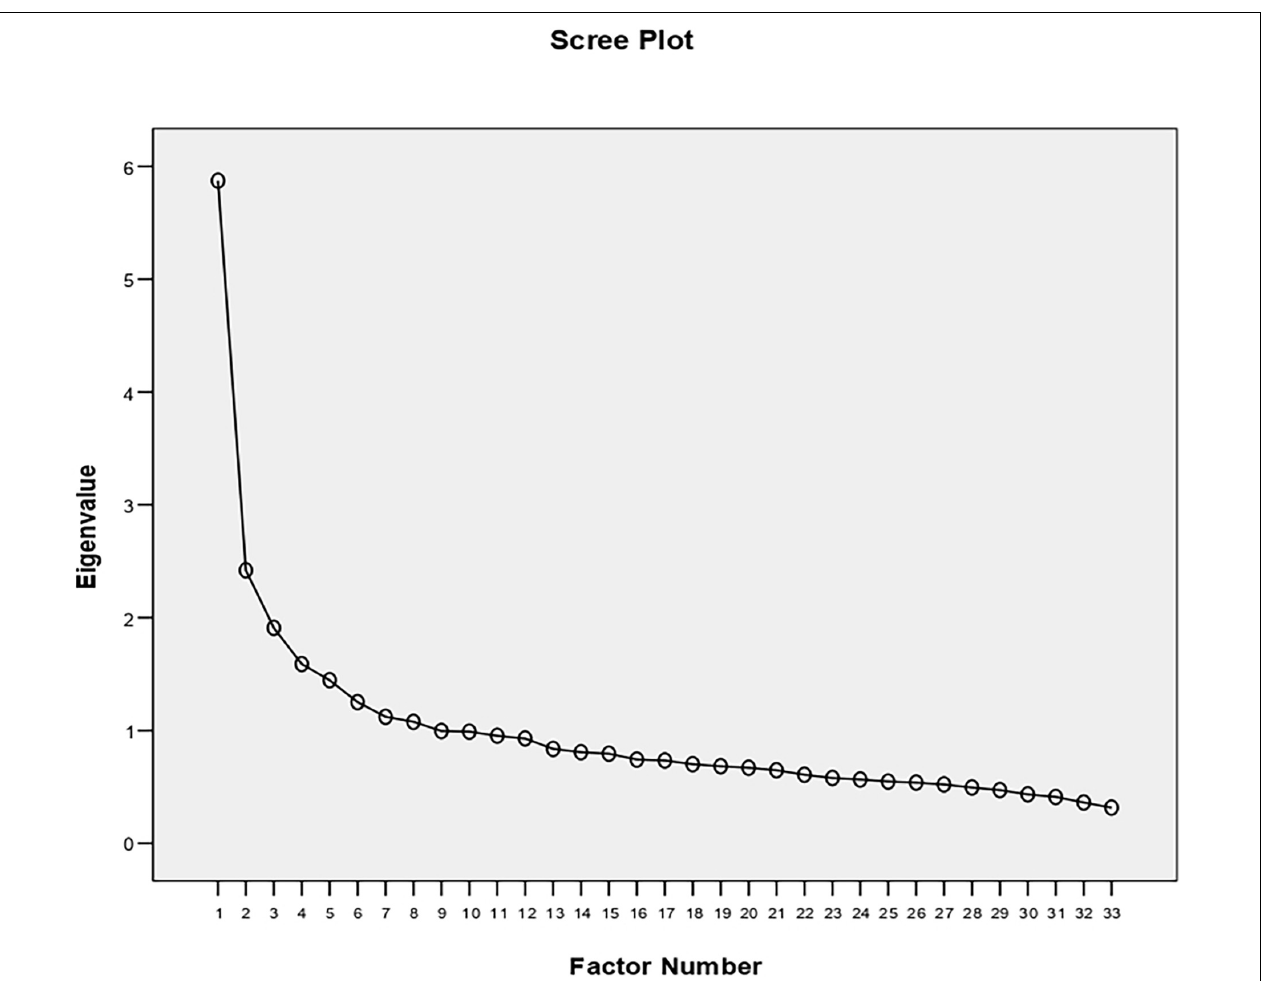
FIGURE 1 | Scree plot of EFA ( N =